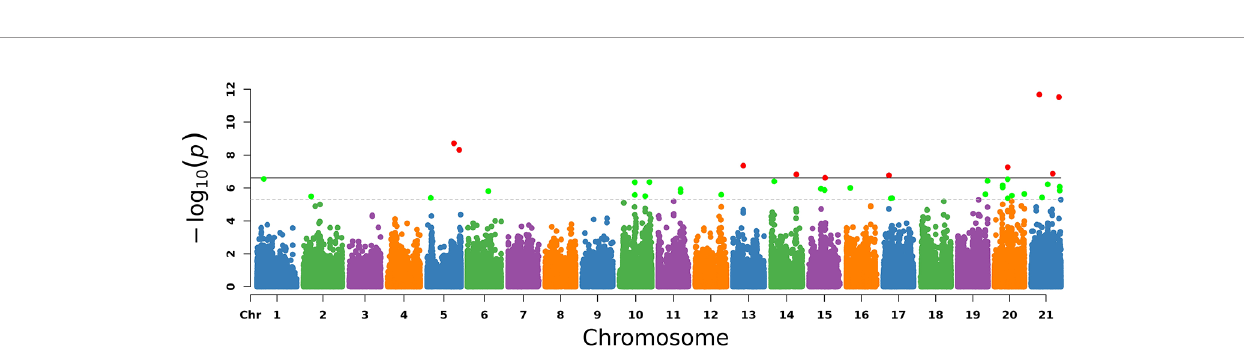
FIGURE 3 | Manhattan plot of – log10 ( P -values) for the egg laying traits in chromosome order. Each simulated chromosome contains 50 million bases. The solid line indicates the 5% signi fi cance level and the dotted line indicates the suggested level that extended the threshold to 20 times. The red points and green points are the signi fi cant